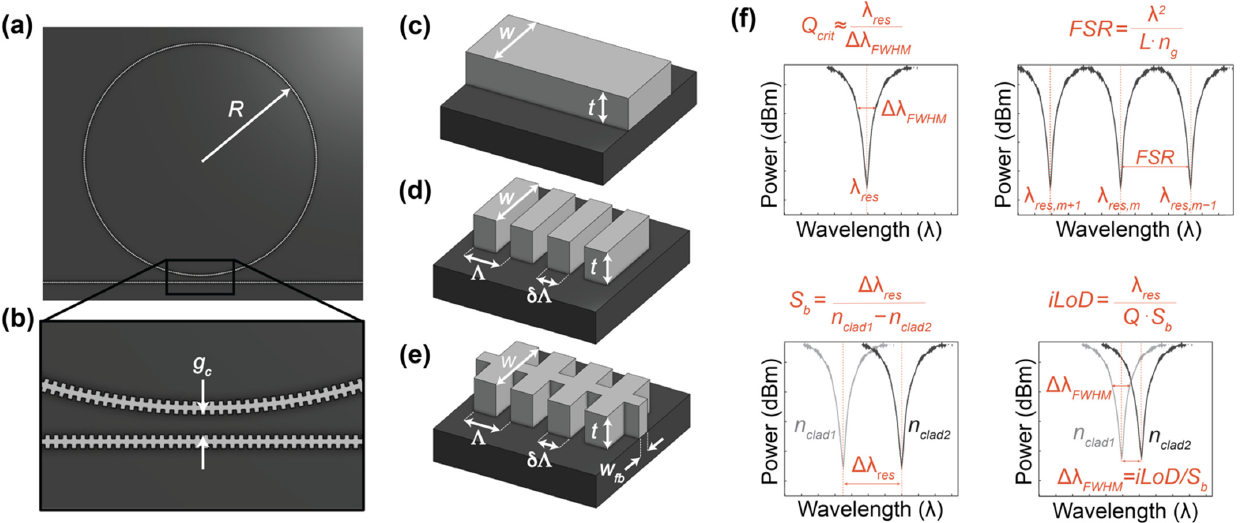
Figure 1. ( a ) Illustration of microring resonator (MRR) with radius R fabricated with fishbone sub- wavelength grating (SWG) waveguides and ( b ) expanded view of bus-to-ring coupling region with coupling gap g c . Illustrations of ( c ) strip, ( d ) conventional SWG, and ( e ) fishbone SWG waveguide geometries with width w , thickness t , grating period Λ , duty cycle δ , and fishbone width w fb . ( f ) Graphical representations of MRR performance criteria, including (clockwise from top left) critically coupled quality factor ( Q crit ), free spectral range ( FSR ), intrinsic limit of detection ( iLoD ), and bulk sensitivity ( S b